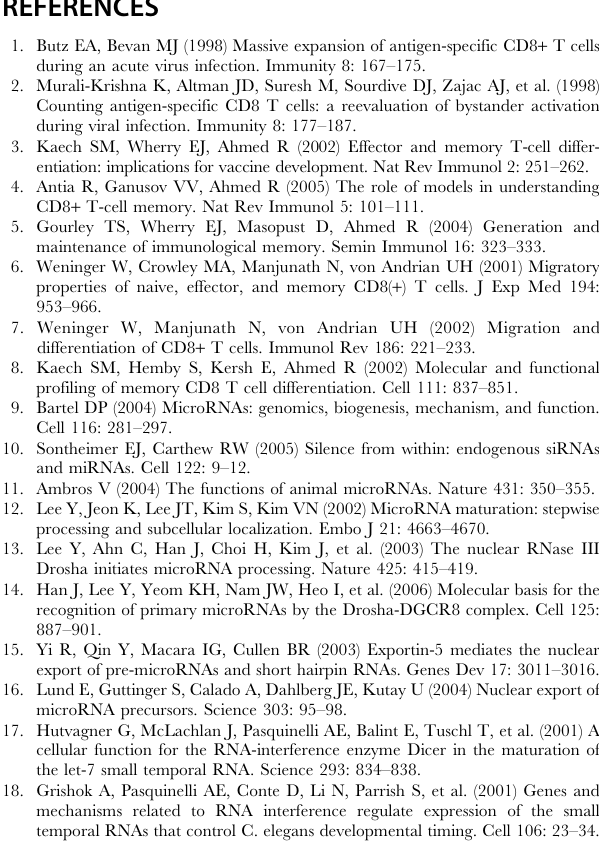
Table S2 Microarray analysis of cloned miRNAs also reveals differential expression in T cell subsets. Hybridization signals obtained in the microarray for miRNAs that were identified by direct cloning are shown.